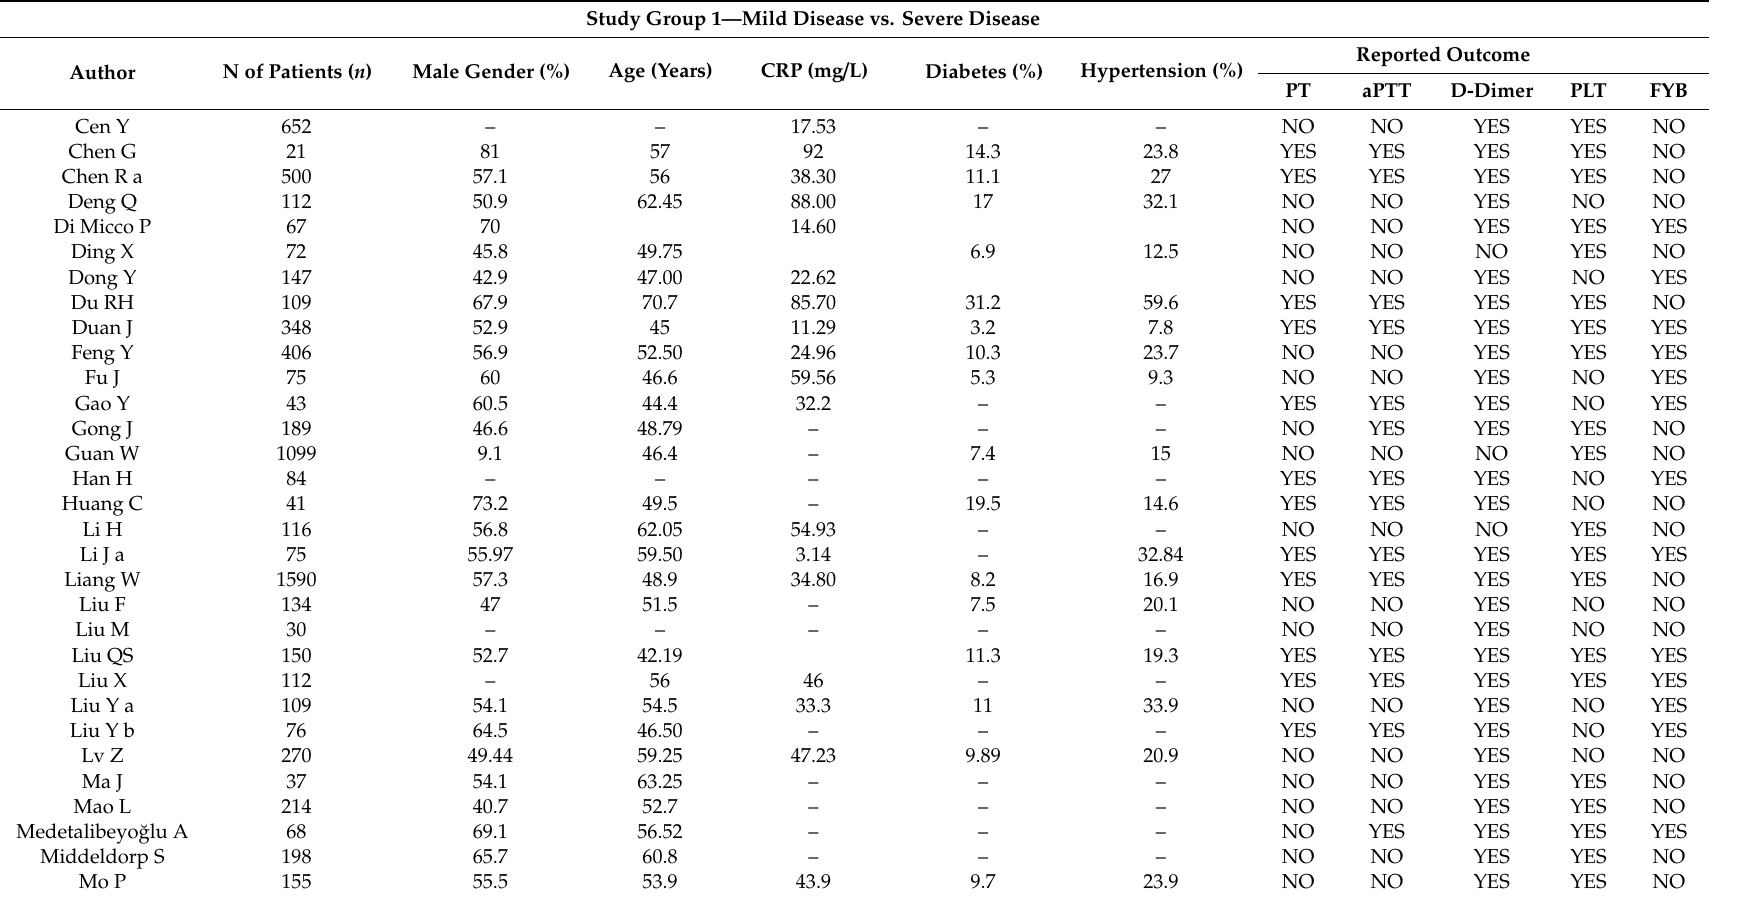
Table 1. Clinical and demographic characteristics of patients with COVID-19 included in di ff erent studies. Study Group 1—Mild Disease vs. Severe